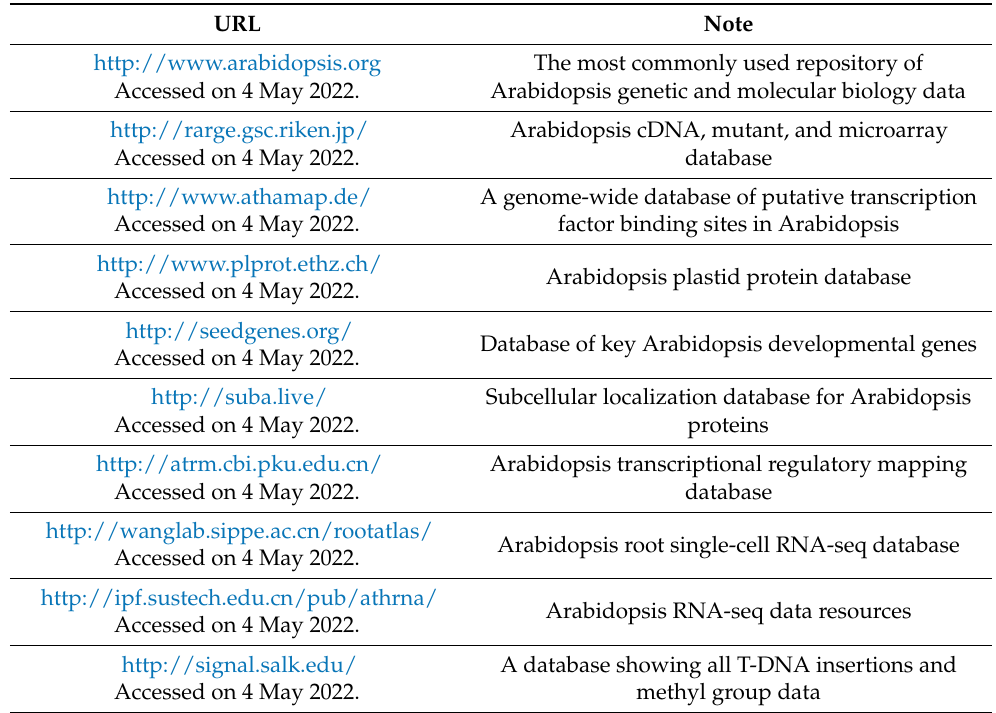
Table 2. Databases specific for